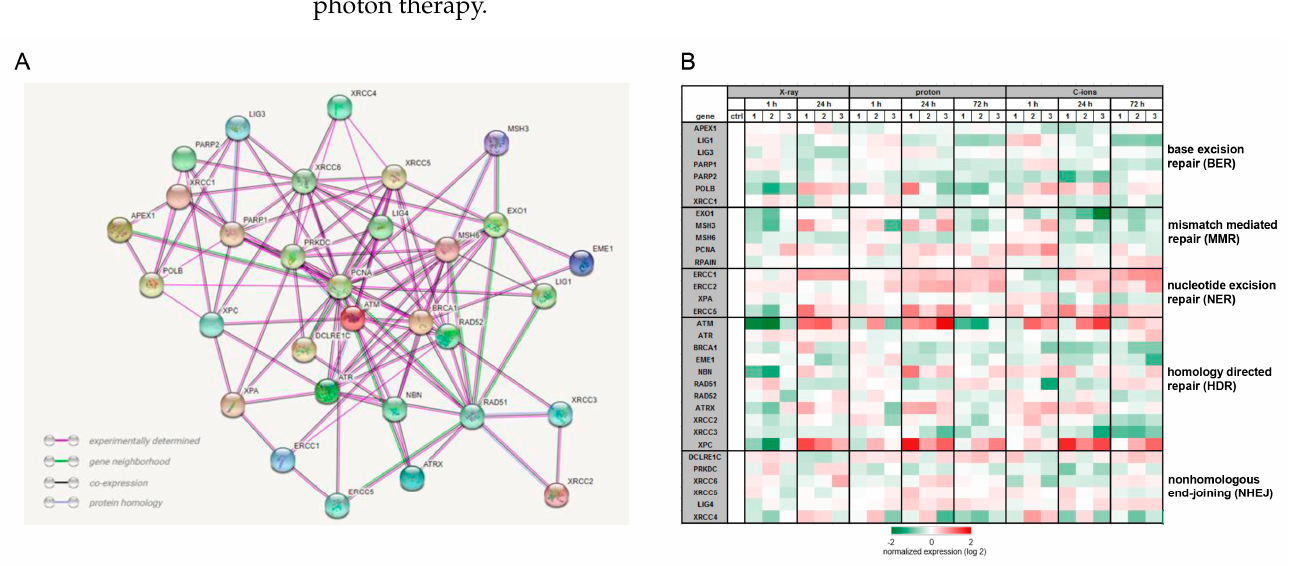
Figure 5. Expression of DNA repair key genes. ( A ) The interaction network was prepared using the STRING database (version 11.5; string consortium 2022; http://www.string-db.org), collected from different databases. Experimental determined connections were presented with magenta lines, gene neighborhood (green), co-expression (black), and protein homologies (blue). ( B ) Heatmap blot of RNA next generation sequencing data of the key players of DNA repair mechanism pathways presented in log2 fold change 1 h, 24 h, and 72 h after 4 Gy X-ray/proton/C-ions IR ( n = 4).